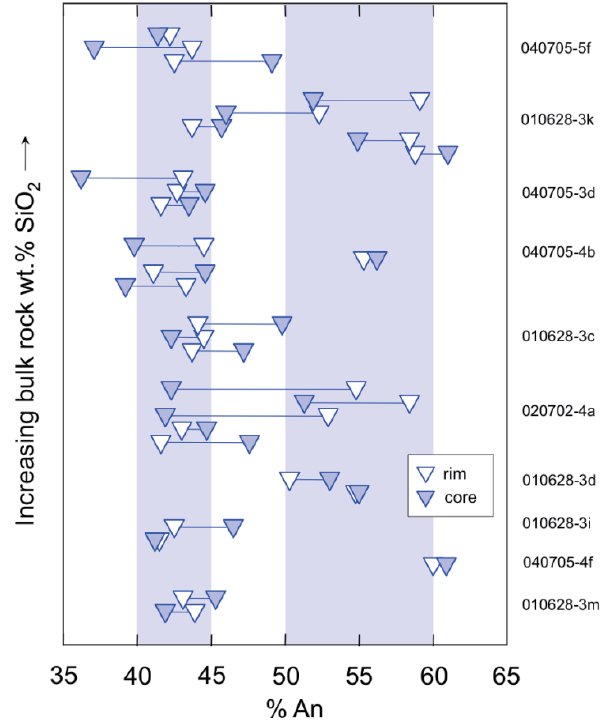
content of the host pumice fragment (sample numbers are 2 and An and (2) An to An 41 45 50 60